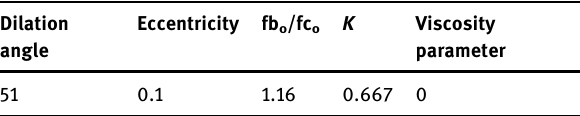
Table 1: Damage plasticity model parameters Dilation